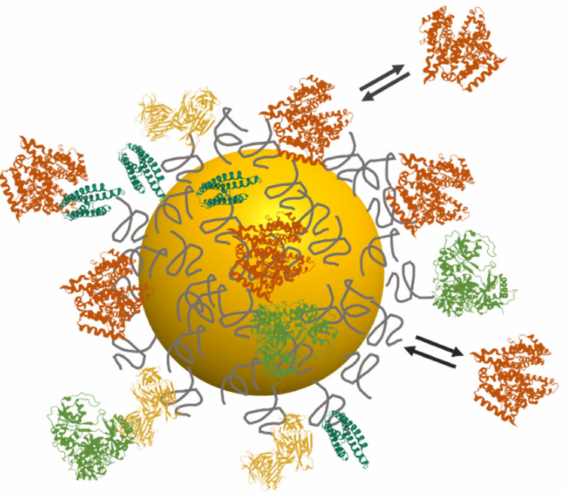
Figure 5. Schematic showing an NP surrounded by surface organic ligands and coated with various strongly bound proteins (hard corona) and weakly bound proteins in equilibrium with proteins in solution (soft